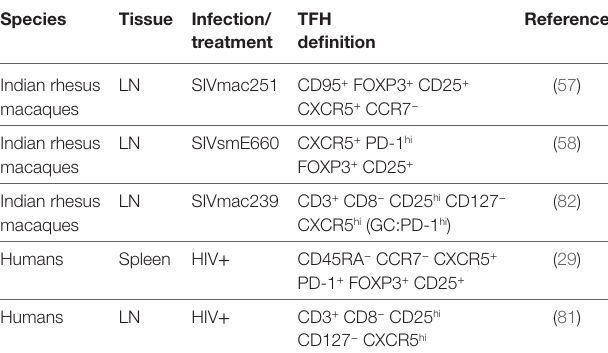
TabLe 2 | Markers to define TFR cells in cell suspension in humans and macaques. Species Tissue infection/ TFH treatment definition